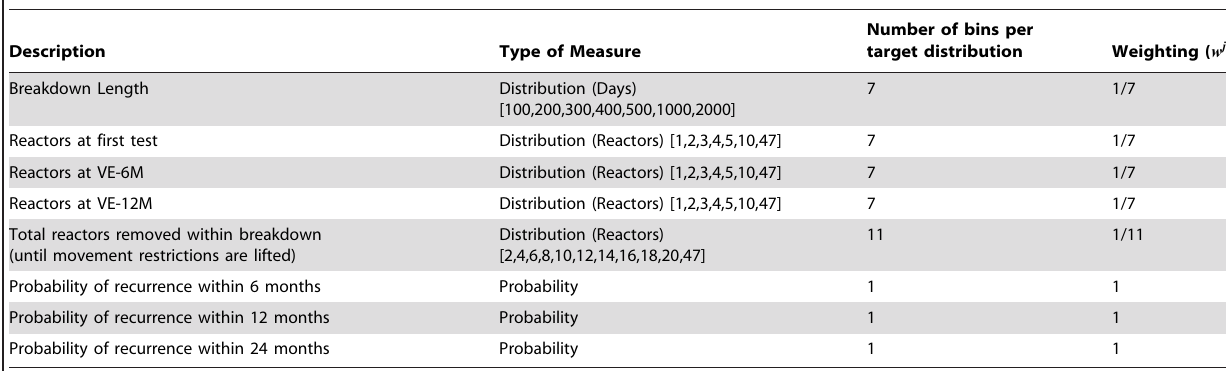
Table 5. Epidemiological target measures for